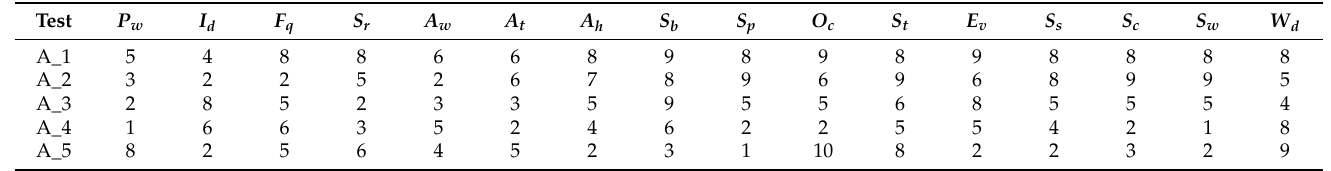
Table 4. Orthogonal test parametric arrangement for sprinkler drip irrigation in loam soil.